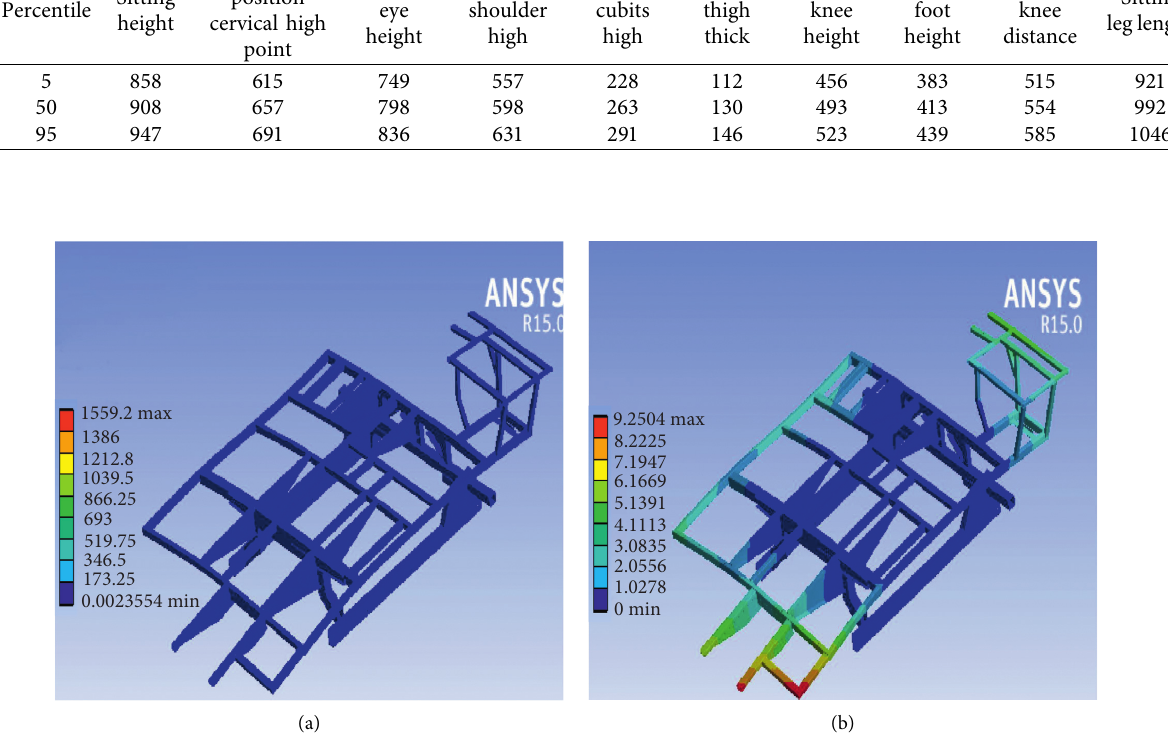
Figure 5: Low-speed full-load stress-strain diagram. (a) Equivalent stress diagram at low speed and full load. (b) Strain distribution at low speed and full